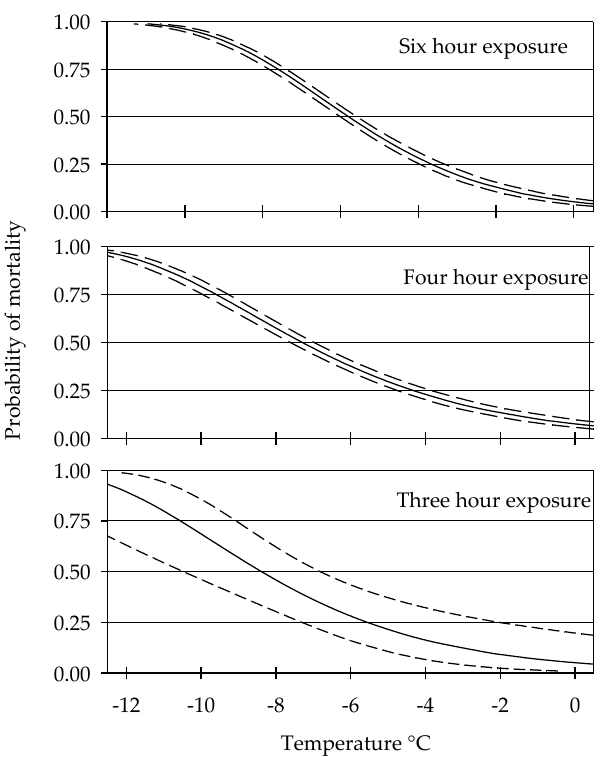
Figure 2. Probit models for exposure to three, four, and six hours of sub-freezing temperature.